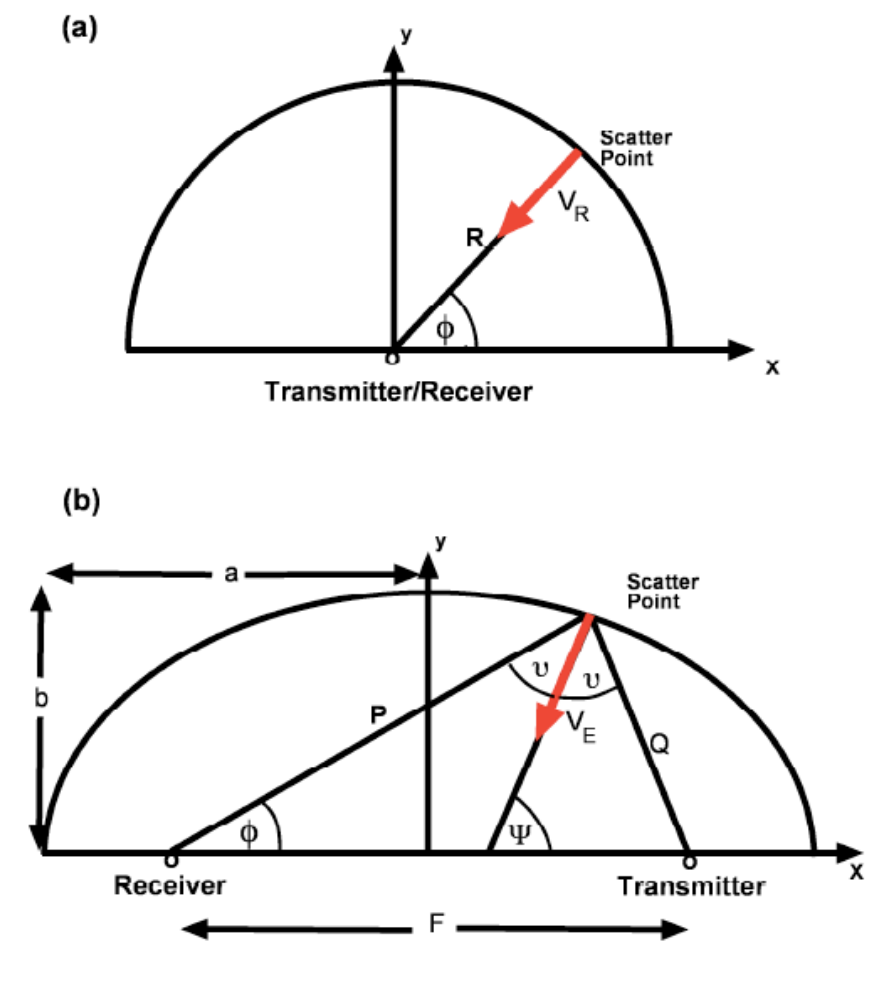
Figure 3. Schematic diagrams of radar configuration (a) Backscatter from a circle of radius R around the transmitter/receiver location, showing azimuth angle  of the received signal; (b) Bistatic scatter from an ellipse with receiver and transmitter at the focal points separated by distance F . Ellipse major and minor semi-axes a , b , are shown, as well as the azimuth angle φ  of the received signal, the angles of incidence and reflection  , the distances P , Q from the receiver, transmitter to a scatter point on the ellipse, and the slope  of the normal to the ellipse at the scatter